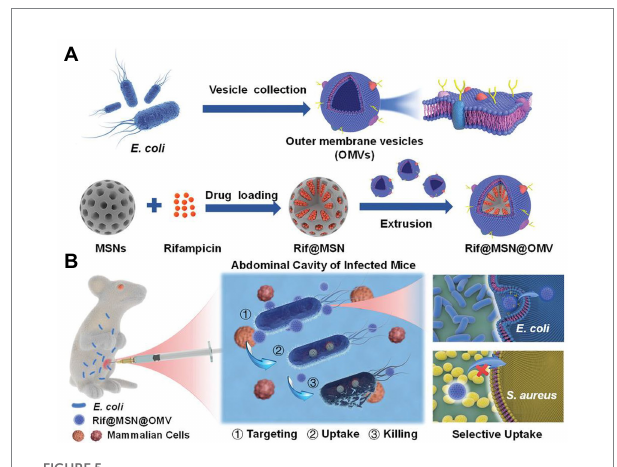
FIGURE 5 Schematic illustration of (A) the preparation process and (B) the application of OMV-coated biomimetic nanodelivery system Rif@ MSN@OMV in bacterial infection. OMV modification achieved homotypic targeting capacity and enhanced uptake, thus exerting strong antibacterial activity. Reproduced with permission (Wu S. et al., 2021; Copyright© 2021, Wiley-VCH) OMV, outer membrane vehicles; Rif, rifampicin; MSN, mesoporous silica nanoparticles; E. coli , Escherichia coli